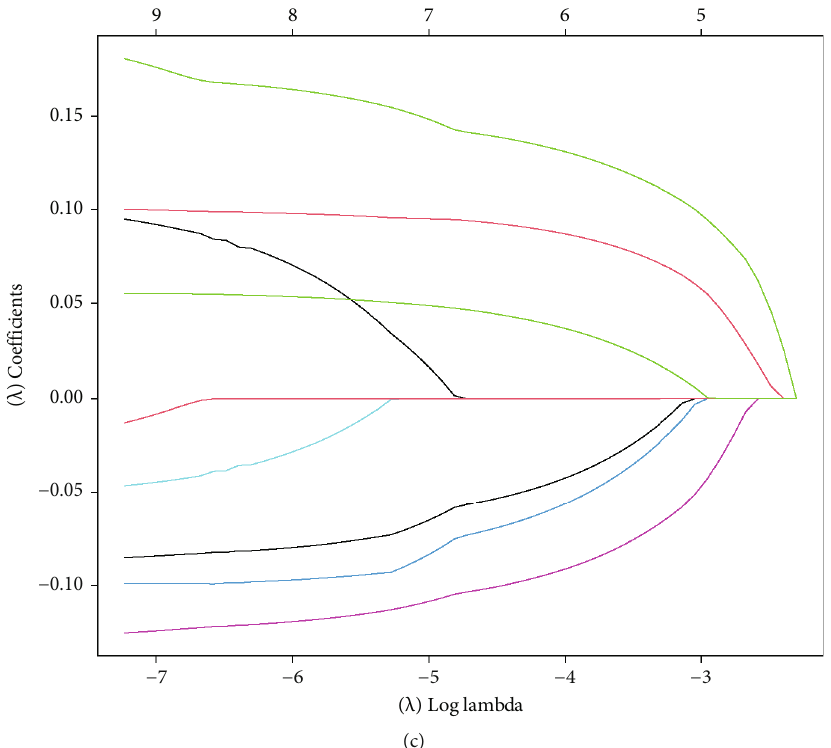
Figure 2: Construction of the signature. (a) Univariate Cox regression analysis screening nine MTRGs associated with prognosis of LUAD. (b) LASSO analysis exploring the minimum lambda value. (c) LASSO detecting six genes for signature construction according to the minimum lambda